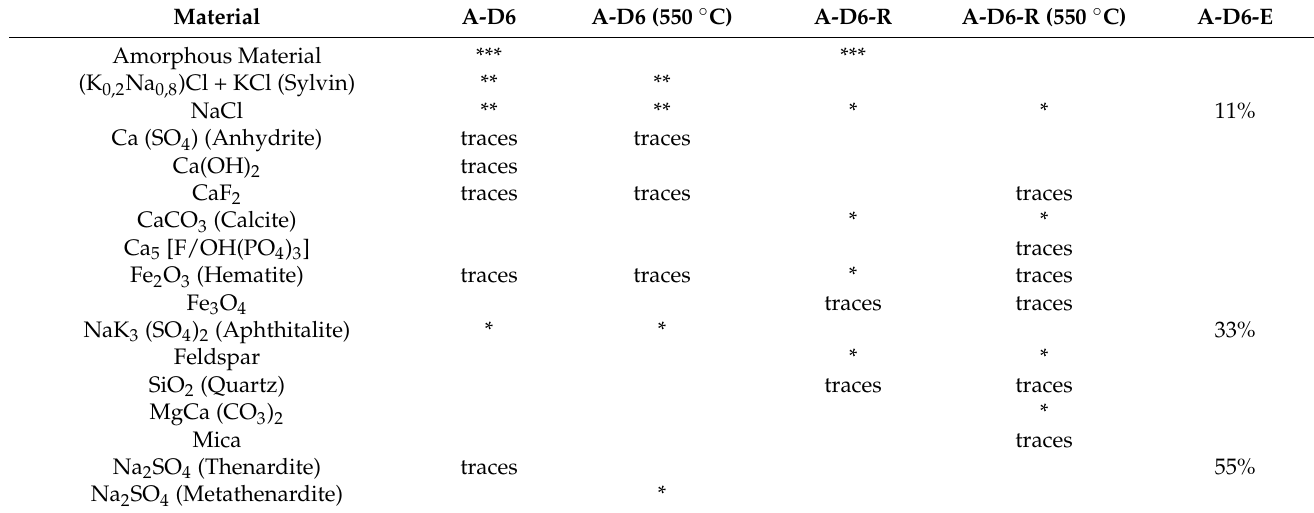
Table 4. Results of the XRD investigation and semiquantitative